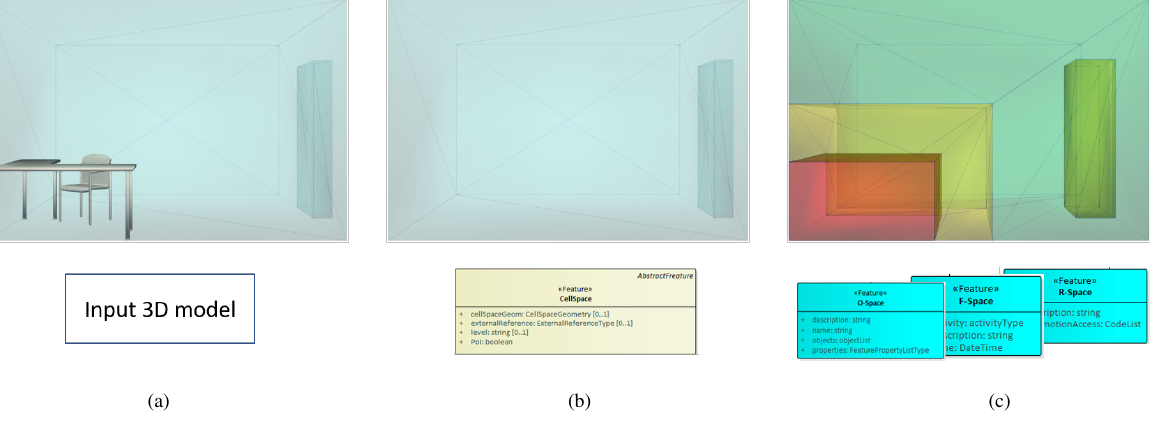
Figure 5. Different IndoorGML layers of a same space. (a) Original 3D model of a room space with furniture. (b) CellSpaces forming the first topographic layer. (c) Second topographic layer composed of FSS subspaces of the original model.